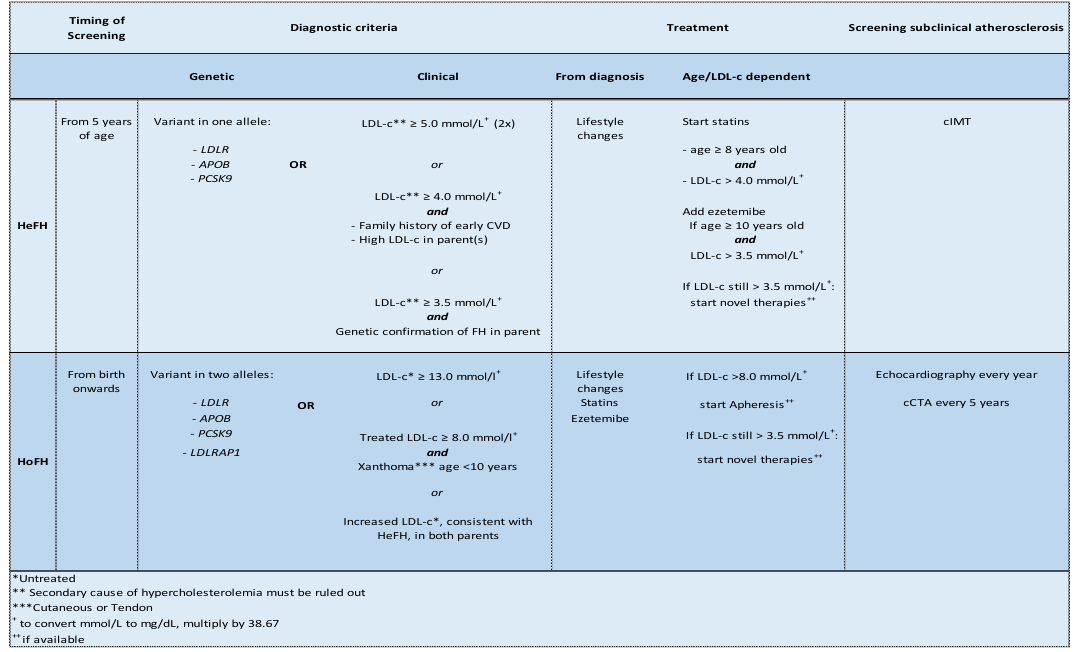
Figure 1. Overview of key aspects of timing of screening, diagnostic criteria (genetic and clinical), treatment, and options for screening for subclinical atherosclerosis as stated by the EAS. Children suspected for HeFH or HoFH need to be screened from 5 years of age and from birth onwards, respectively. When genetic confirmation is not possible, clinical diagnostic criteria can be used based on LDL-C levels, family history, or patient’s characteristics. In both HeFH and HoFH, lifestyle changes are needed from diagnosis, while the start and type of treatment differ between HeFH and HoFH and depend on age and LDL-C levels. Screening for subclinical atherosclerosis is possible in HeFH (in research setting) but recommended in HoFH.